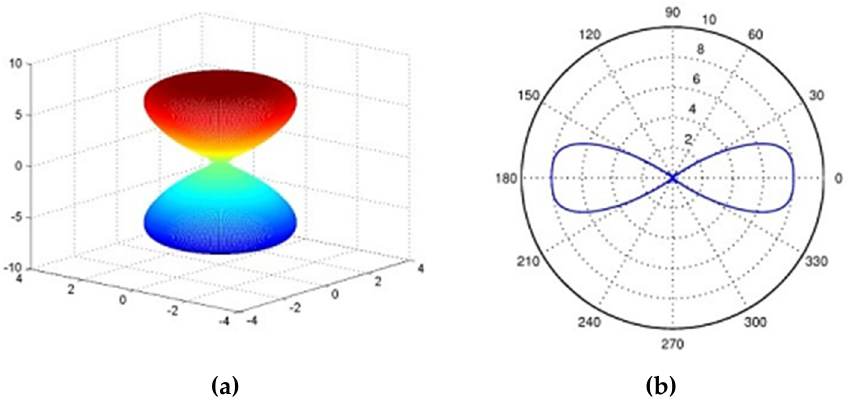
Figure 6. Illustrations of a sensor radiation pattern ( a ) 3D dimension ( b ) 2D dimension.